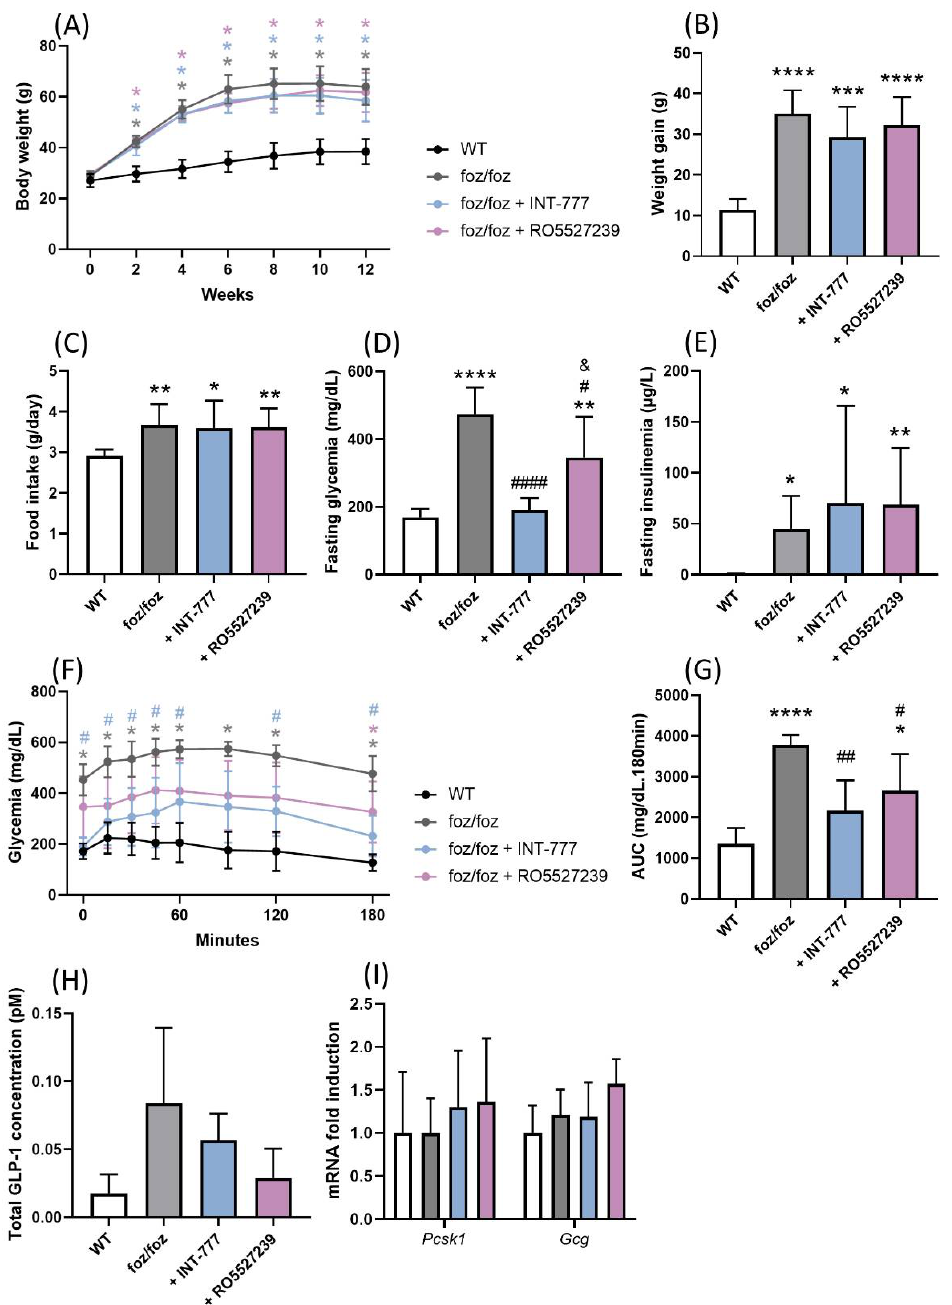
Figure 5. INT-777 and RO5527239 improve glucose tolerance in a GLP-1-independent manner. ( A ) Body weight evolution, ( B ) body weight gain over the 12 weeks, ( C ) mean food intake, ( D ) fasting glycemia and ( E ) fasting insulinemia of WT, foz/foz , foz/foz + INT-777 and foz/foz + RO5527239 mice (n = 7/group). ( F ) Glycemia during the OGTT performed at the end of the experiment and ( G ) AUC for the OGTT. ( H ) Total GLP-1 concentrations in systemic plasma 15 min after a glucose challenge. ( I ) Gene expression of Pcsk1 and Gcg in the colon of WT, foz/foz , foz/foz + INT-777 and foz/foz + RO5527239 mice (n = 7/group). Mean ± SD. One- or two-way ANOVA followed by post hoc Bonferroni correction. Statistical significance is represented by * p < 0.05; ** p < 0.01; *** p < 0.001 and **** p < 0.0001 when compared to WT; # p < 0.05; ## p < 0.01; and #### p < 0.001 when compared to foz/foz ; and & p < 0.05 when compared to foz/foz + INT-777. For ( A , F ), colors are used to indicate the corresponding group. All p -values < 0.05 are represented on the graphs, while p -values > 0.05 are not.